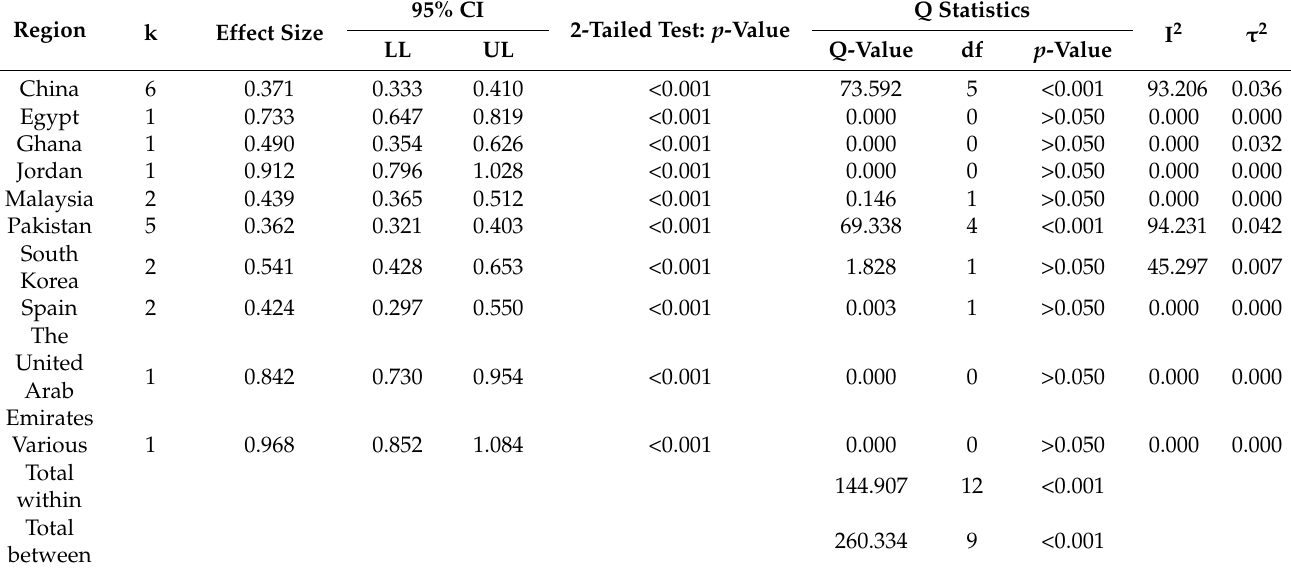
Table 6. Moderating effect